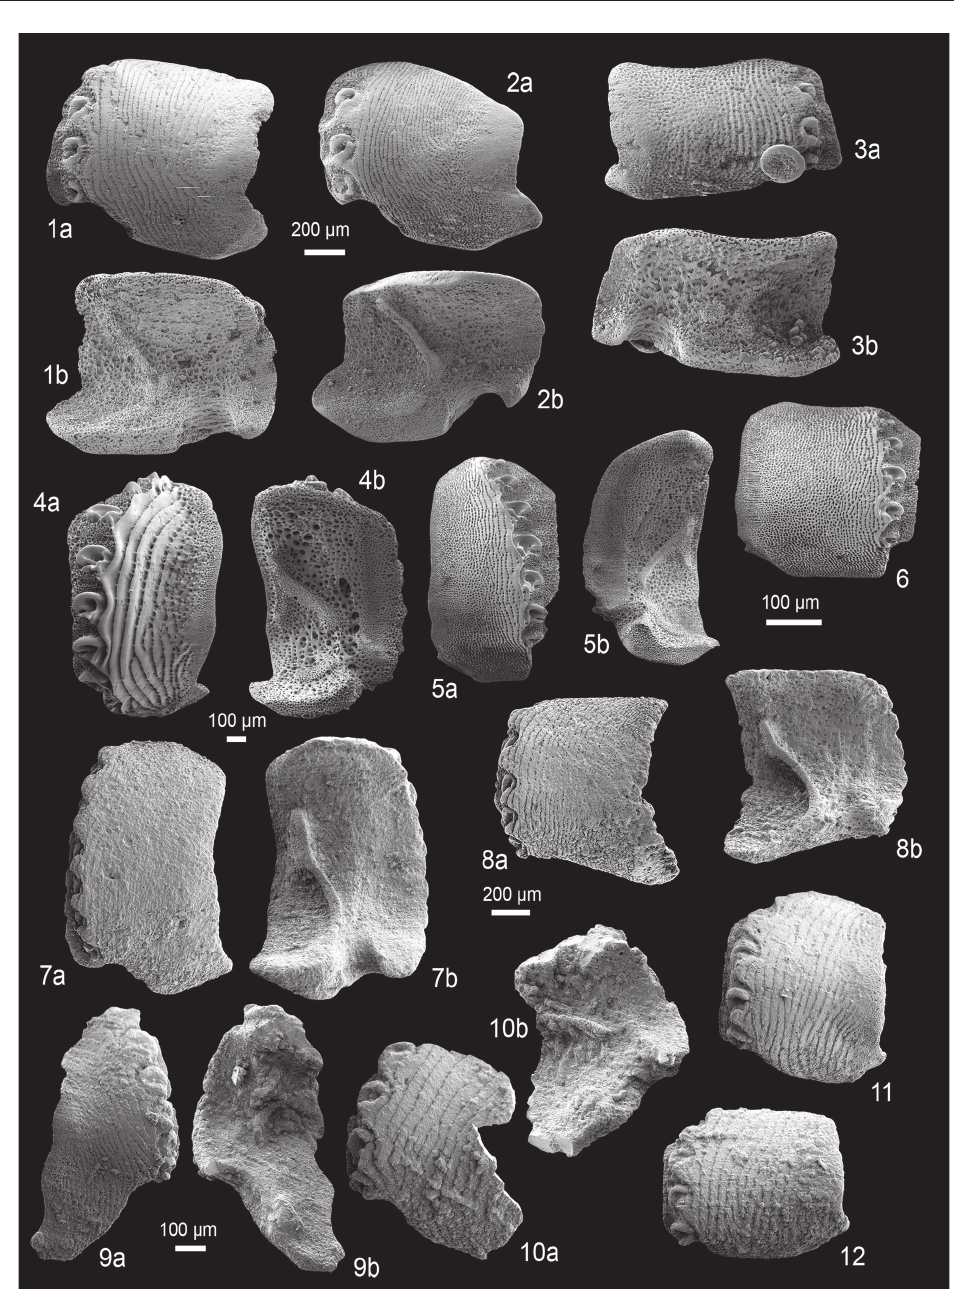
Fig. 13. Lateral arm plates (LAPs) of fossil and Recent ophiacanthid brittle stars in external (a) and internal (b) views. 1-3. Ophiotoma incredibilis sp. nov. from the latest Aptian to earliest Albian (Early Cretaceous) of Blake Nose, NE Atlantic. 1. GZG.INV.78549 (holotype), proximal LAP. 2. GZG. INV.78550 (paratype), median LAP. 3. GZG.INV.78551 (paratype), distal LAP. 4. Ophiolimna antarctica (Lyman, 1879), Recent, proximal LAP. 5-6. Ophiolimna perfida (Koehler, 1904), Recent. 5. Proximal LAP. 6. distal LAP. 7-8. Ophiolimna tiamatia sp. nov. from the late Sinemurian to early Pliensbachian (Early Jurassic) of the Glasenbach Gorge, Austria. 7. NHMW 2012/0137/0010 (holotype), proximal LAP. 8. NHMW 2012/0137/0011 (paratype), median LAP. 9-12. Ophiolimna malagasica sp. nov. from the Bathonian (Middle Jurassic) of Jumara, India. 9. GZG.INV.78553 (holotype), proximal LAP. 10. GZG.INV.78554 (paratype), median LAP. 11. GZG.INV.78555 (paratype), median LAP. 12. GZG. INV.78556 (paratype), distal LAP. One common scale bar per species is